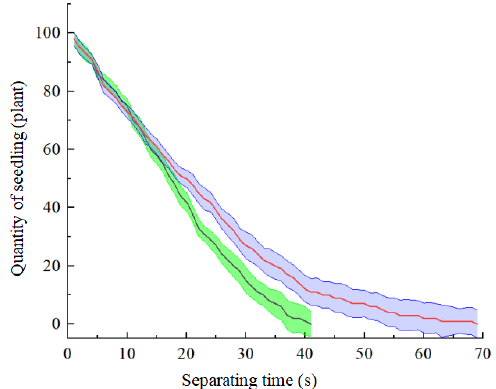
Figure 9. Variation curve of seedling quantity with time. The width of the green and blue bands represents the error band of the number of seedlings in the separation container over time.